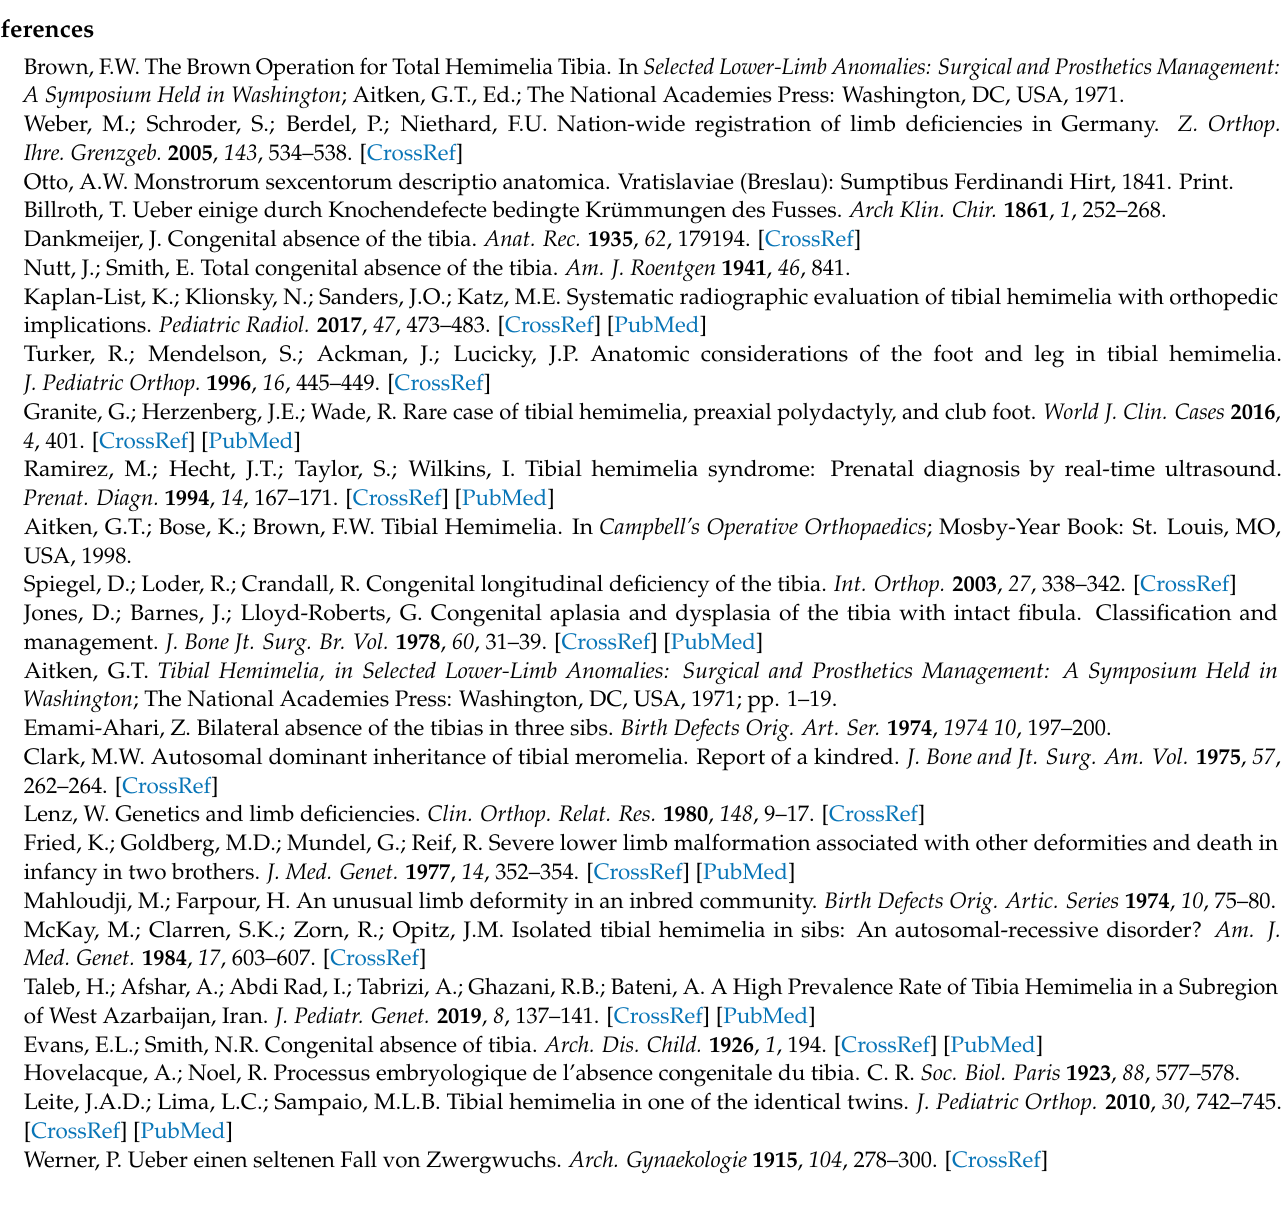
figure preparation, D.Y.C. Conceptualization, writing—review and editing, figure preparation, super- vision, D.P. All authors have read and agreed to the published version of the